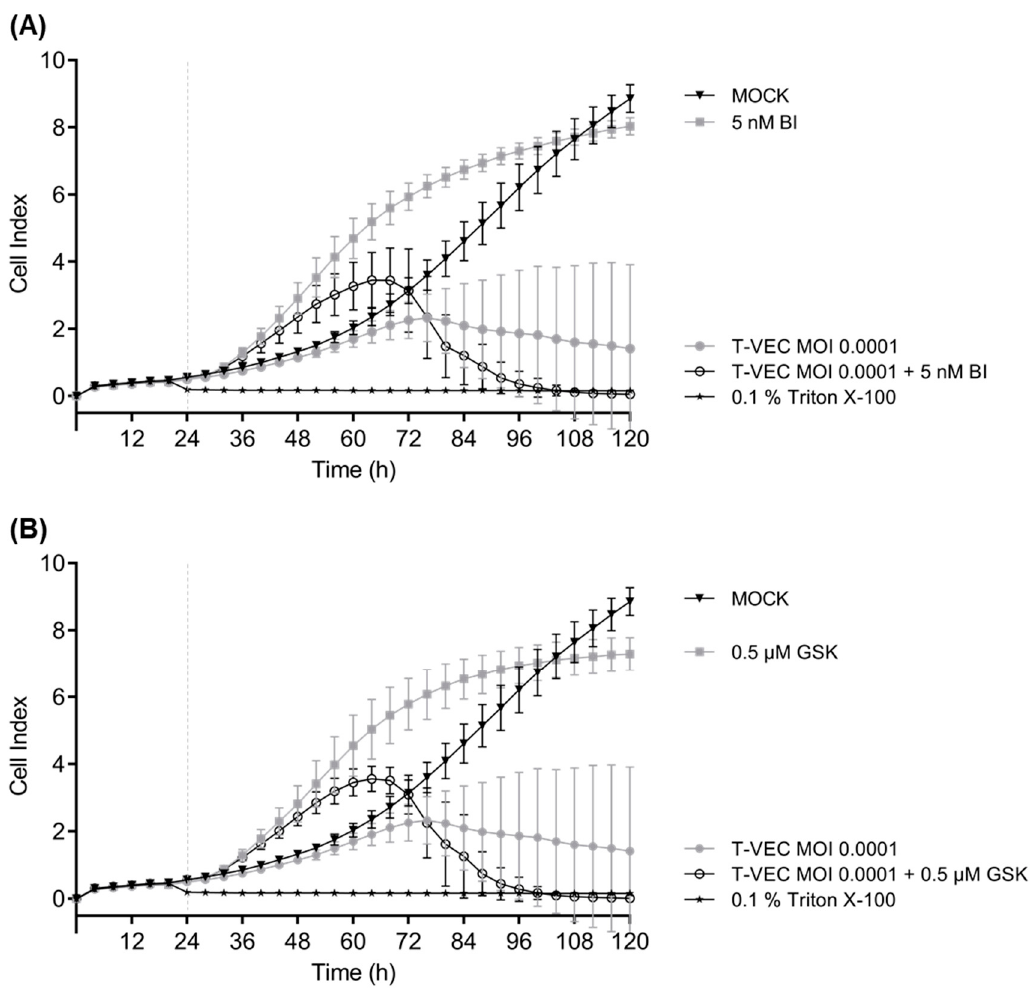
Figure 5. Real-time analysis of 143100 NC cells treated with T-VEC alone or after combinatorial treatment with the BET inhibitors BI894999 (BI) ( A ) or GSK525762 (GSK) ( B ). 24 h after seeding, 143100 NC cells were infected with T-VEC (MOI 0.0001) alone or in combination with 5 nM BI ( A ) or 0.5 µM GSK ( B ) or remained untreated (MOCK). Triton X-100 was added as a negative control inducing maximum lysis of tumor cells. Real-time cell proliferation was monitored using the xCELLigence ® RTCA SP system. Measured electrode impedance is expressed as cell index. One representative of two independent experiments performed in triplicates is shown. Vertical dashed lines indicate the time point of T-VEC infection.